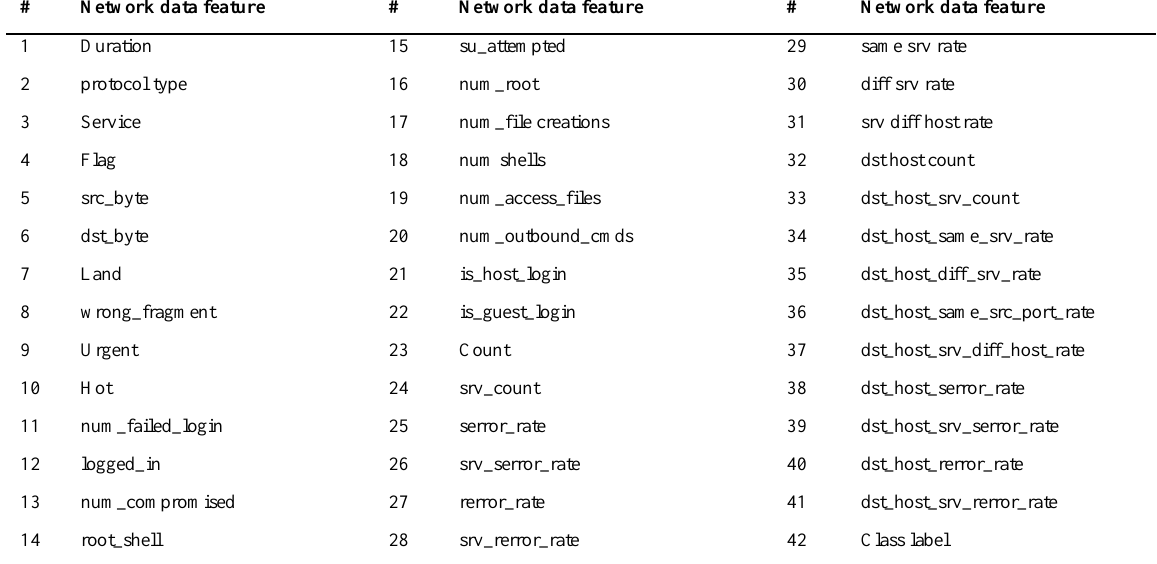
Table 1. Network data